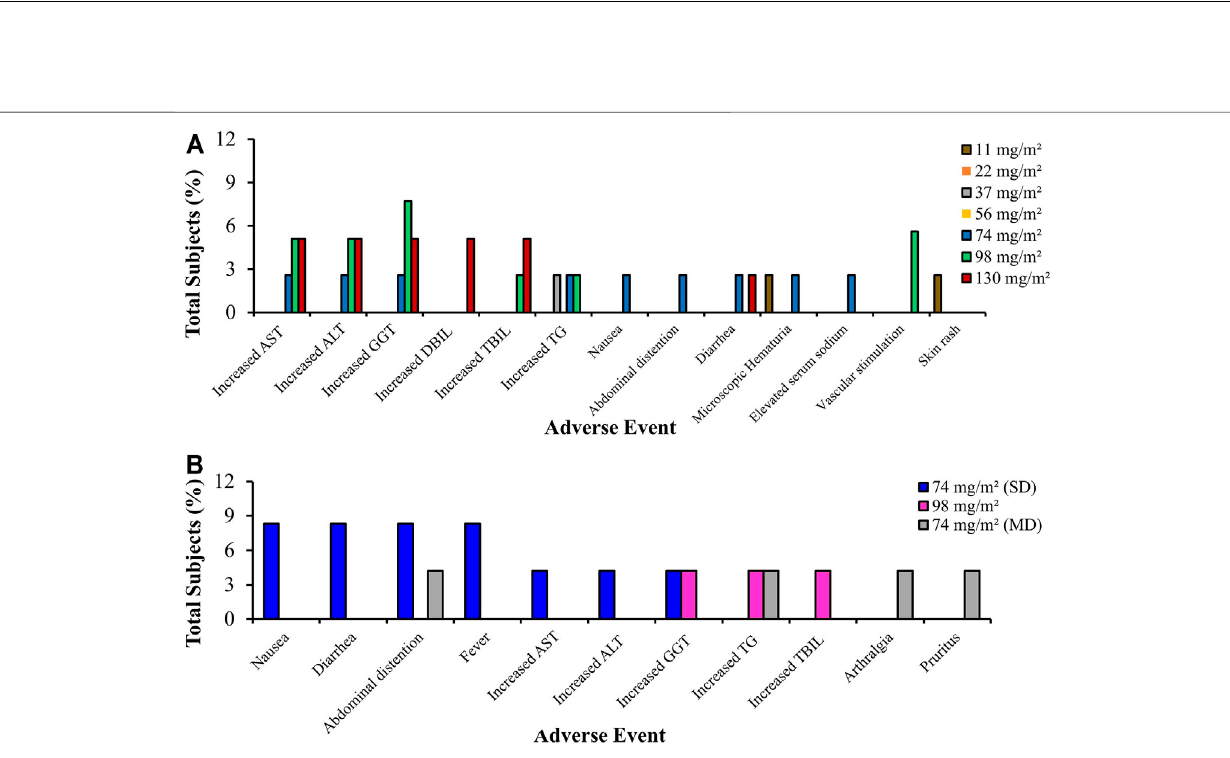
Frontiers in Pharmacology |